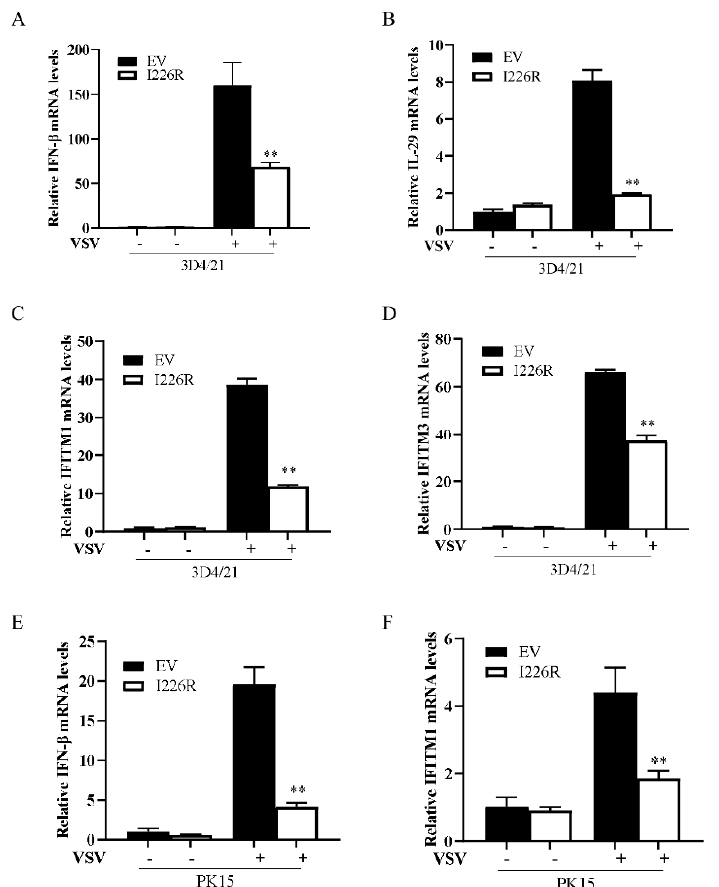
Figure 4. The I226R protein inhibits VSV-induced expression of IFN- β and ISGs in swine cells: ( A – D ) 3D4/21 cells stably expressing I226R or EV were generated; then, they were infected with VSV (MOI = 1) for 12 h. RT-qPCR analysis was performed to examine the mRNA levels of IFN- β ( A ), IL29 ( B ), IFITM1 ( C ), and IFITM3 ( D ). ( E , F ) PK15 cells stably expressing I226R or EV were generated; then, they were infected with VSV (MOI = 1) for 12 h. RT-qPCR analysis was performed to detect the mRNA levels of IFN- β ( E ) and IFITM1 ( F ). All the results are expressed as the means ± standard deviation from three independent experiments. Statistical analysis was performed using the Student’s t -test. ** p <